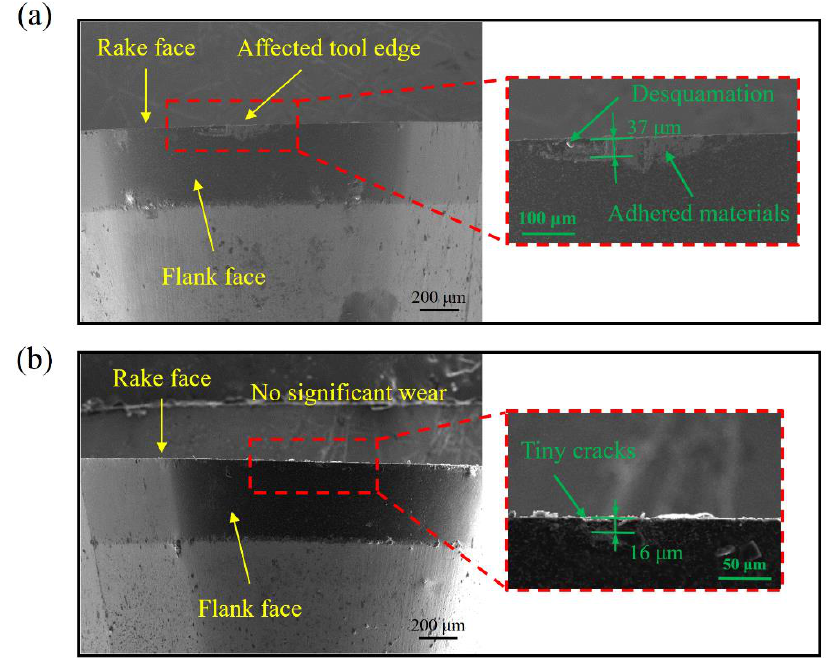
Figure 8. The SEM images of cutting tools under different machining methods: ( a ) the CC tool, ( b ) the UEVC tool.